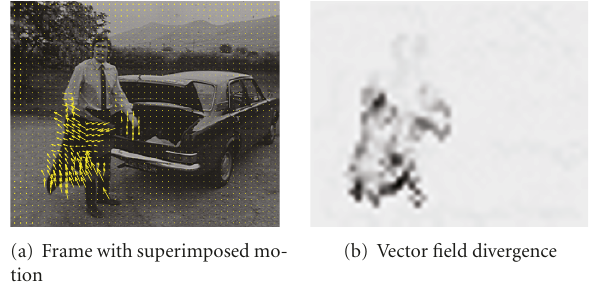
Figure 3: The motion of the jacket in the left image is an example of PM. The motion field in this region is not smooth and as a result the divergence of the motion field in this region has a high absolute value. The dark colours represent high divergence values.